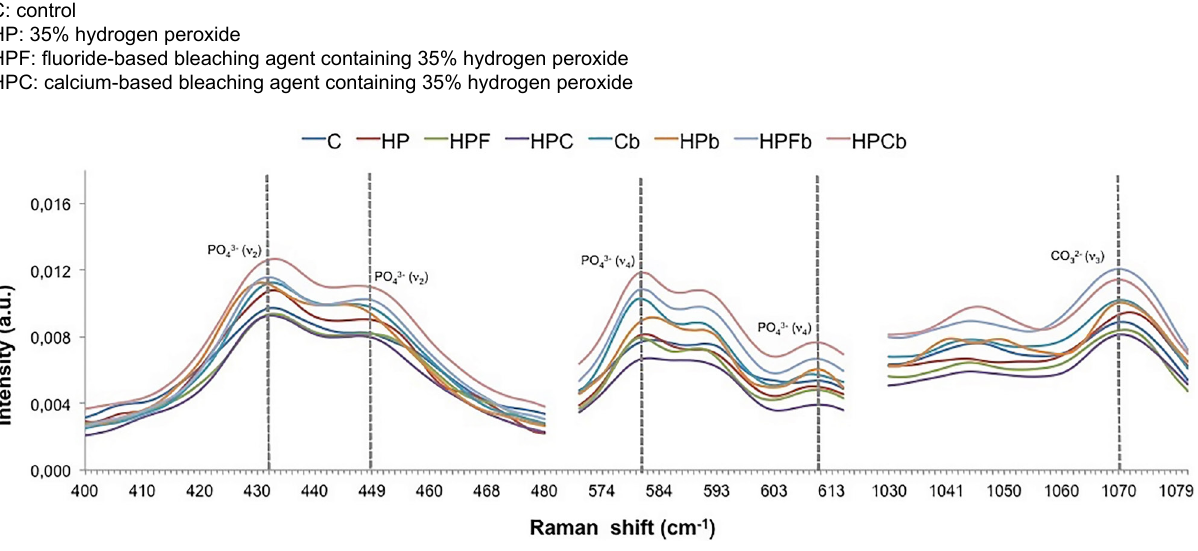
Figure 1- FT-Raman average spectra of mineral components in the 400-1.080cm -1 region showing phosphate peaks ( v 2, 431–449 cm -1 and v 4, 582-611 cm -1 ) and carbonate peak v 3 (1070 cm -1 ) of sound enamel before (C, HP, HPF and HPC) and after (Cb, HPb, HPFb and HPCb) bleaching. It can be noted that after bleaching, groups C, HPF and HPC increased phosphate ( v 2 and v 4) and carbonate ( v 3) contents of enamel, while HP-treated enamel remained with similar inorganic